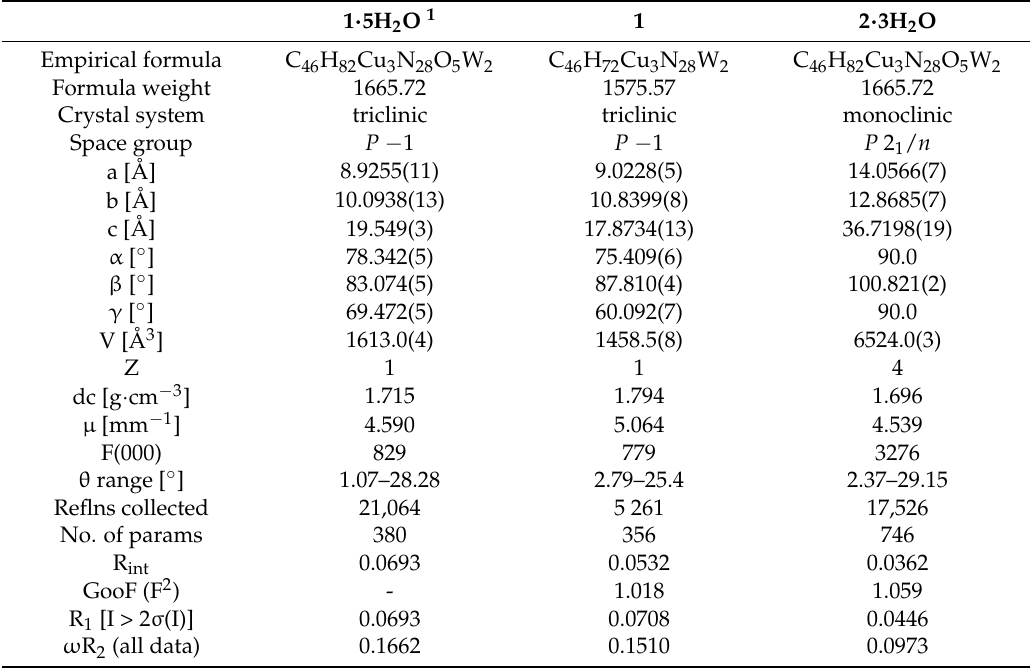
Table 1. Structure and refinement data for 1 and 2 · 3H 2 O ; data for 1 · 5H 2 O included for